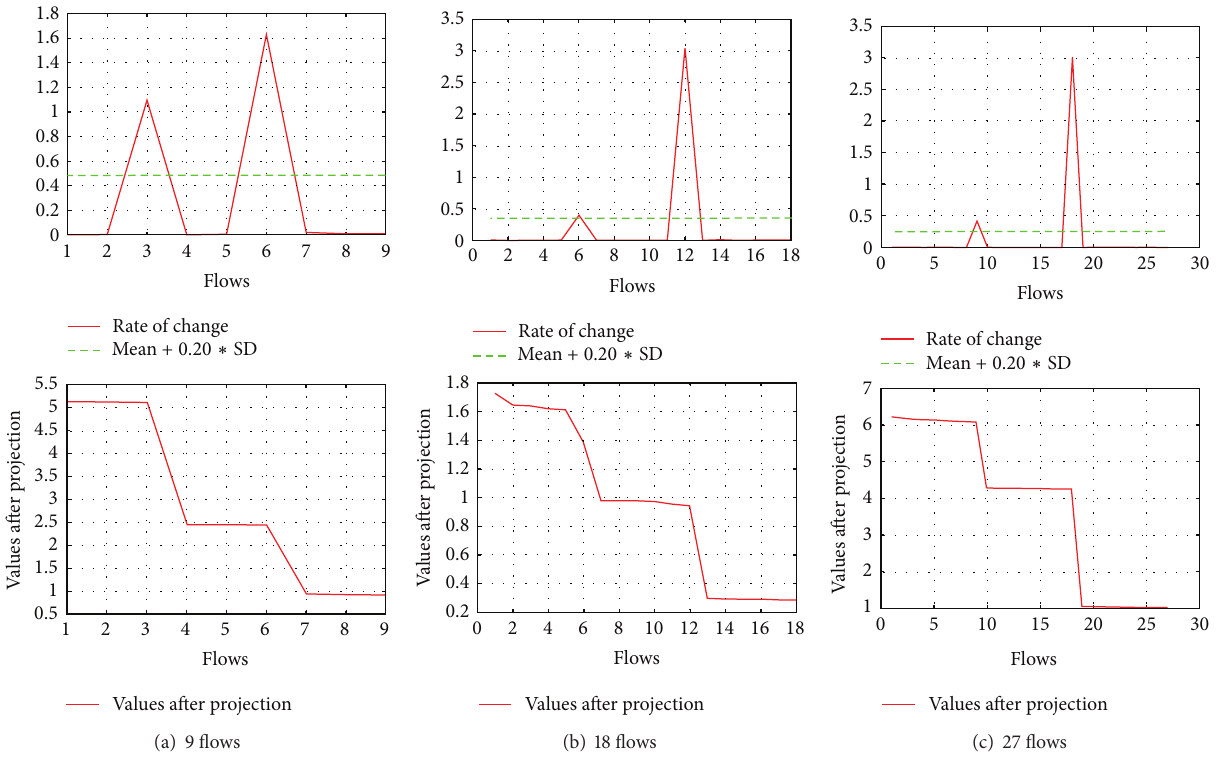
Figure 3: Results of symmetric topology with varying number of flows.